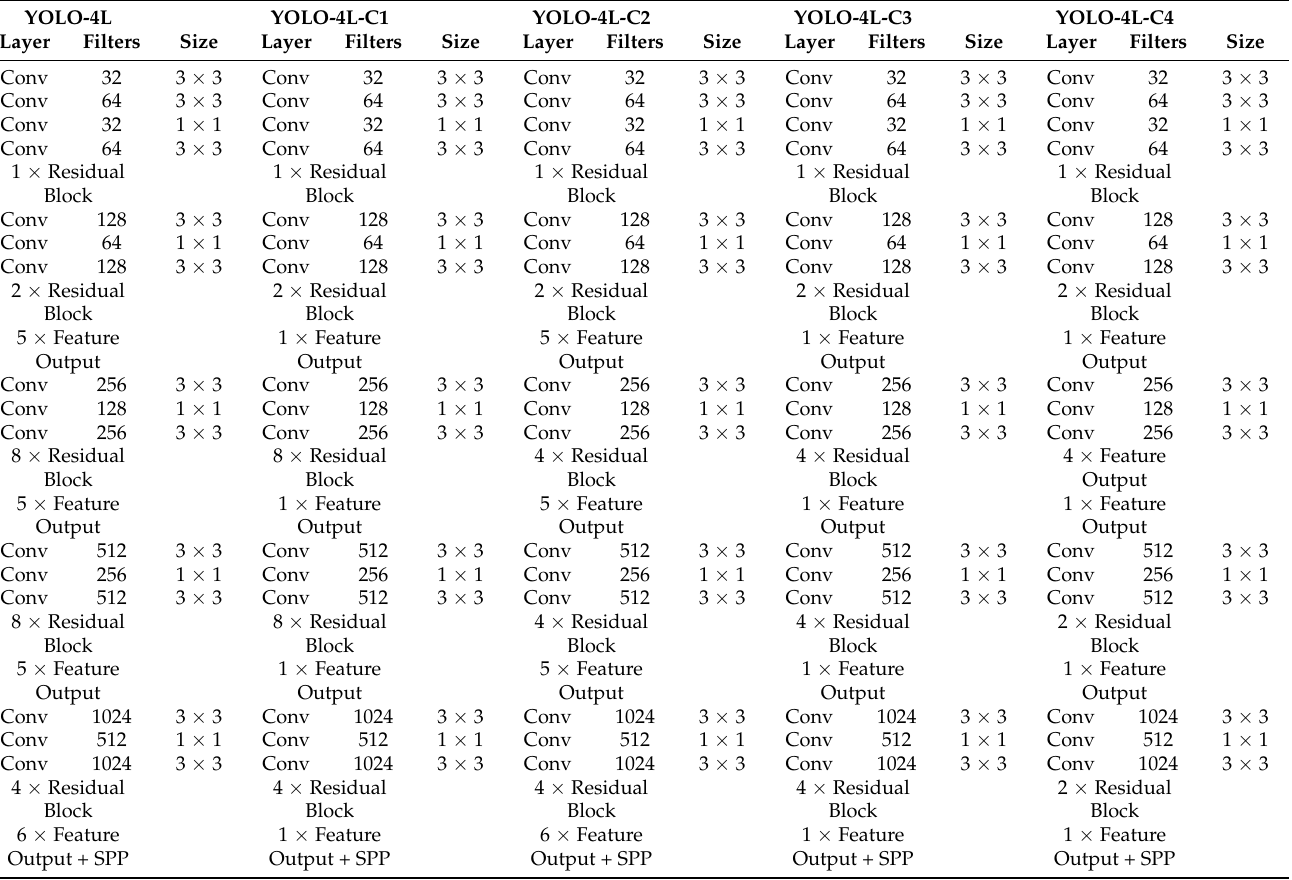
Table 1. YOLO optimization architecture comparison